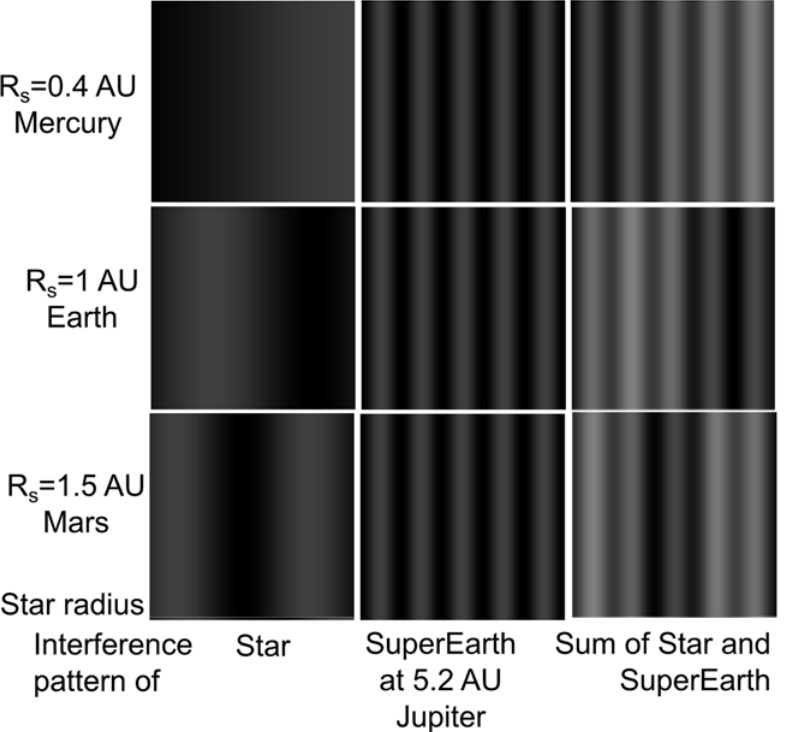
Figure 6. An illustration of the effect of the distance of the star center from the origin of the primed coordinate system (see Figure 1). The text in column 1 presents the displacement of the center of the red giant star. The star centers are located at 0.4 AU, 1 AU and 1.5 AU distances from the coordinate origin. The second column features the interference patterns of the star with itself for three star-center positions. The third column displays the interference pattern of the Super Earth planet with itself, for the specific case of the Jupiter distance of 5.2 AU. The fourth column features the sum of the interference patterns of the red-giant star and the Super Earth planet. The planet interference pattern dominates the sum of the planet and the star incidances.